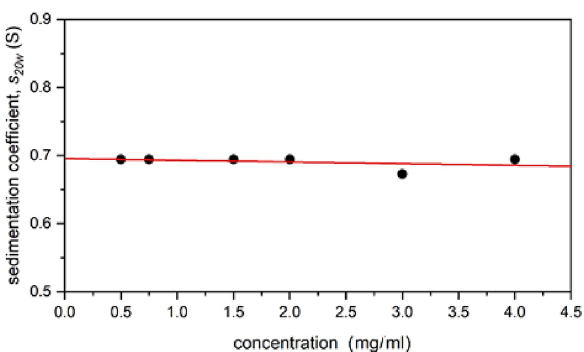
Figure 6. A plot of sedimentation coefficient s 20,w (corrected to standard conditions—the density and viscosity of water at 20.0 °C) against sedimenting concentration. The ideal or “infinite dilution” value, s o 20,w = (0.696 ± 0.007)